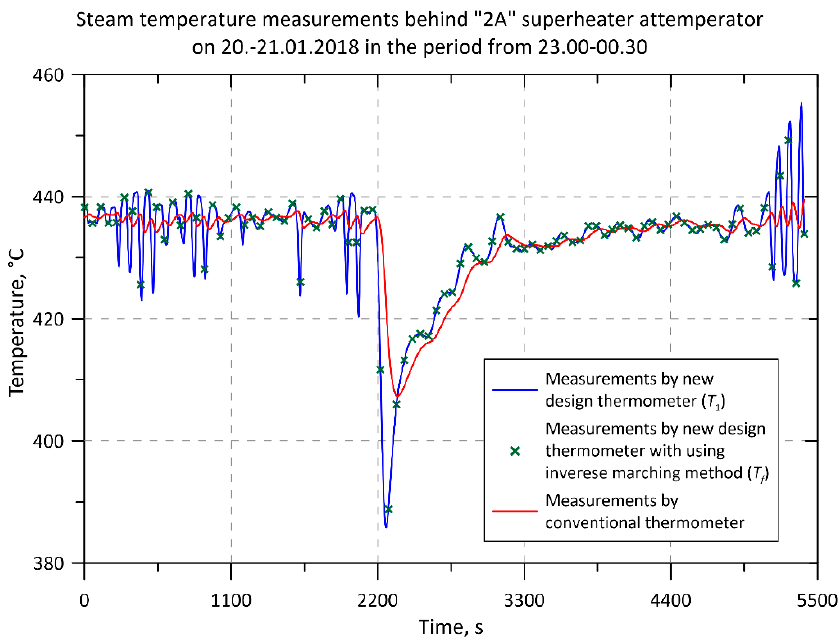
Figure 4. Comparison of superheated steam temperature downstream of the second superheater attemperator measured on side “A” in the K8 boiler by conventional and new design thermometers.